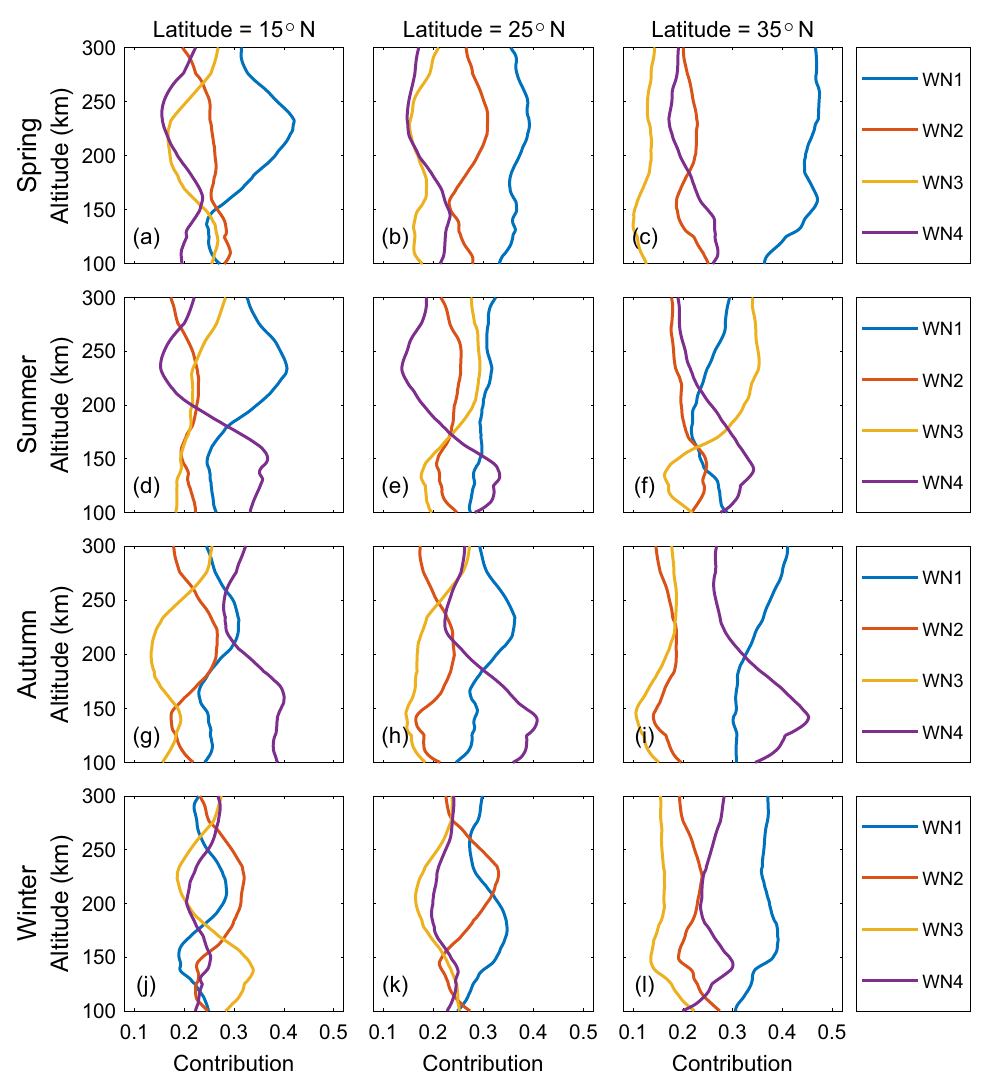
Fig. 3 The contribution of WN1–WN4 to the longitudinal structures in four seasons at three latitudes ( 15 ◦ N , 25 ◦ N , and 35 ◦ N ) from 100 to 300 km. Blue, orange, yellow and purple lines represent WN1, WN2, WN3 and WN4, respectively. a – m Represent the contribution of WN1–WN4 to the longitudinal structure at 15 ◦ N , 25 ◦ N and 35 ◦ N in spring summer, autumn and winter,